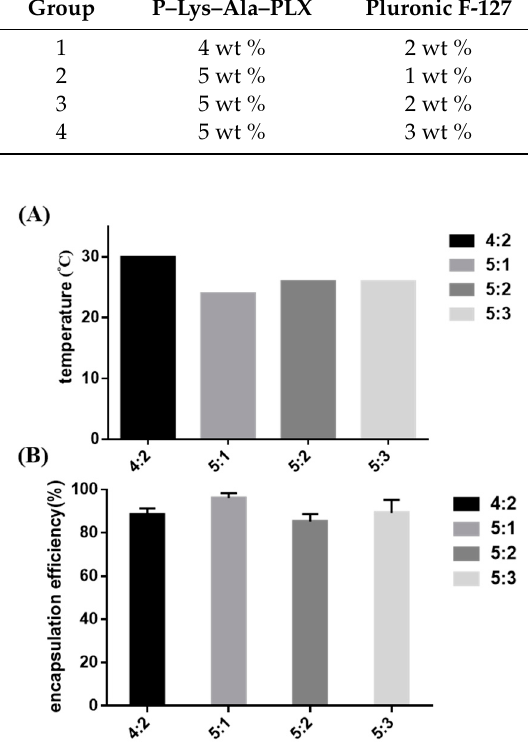
Figure 4. ( A ) The sol-to-gel transition temperature of mixed hydrogels without tacrolimus; ( B ) the encapsulation efficiency of tacrolimus in mixed hydrogels.